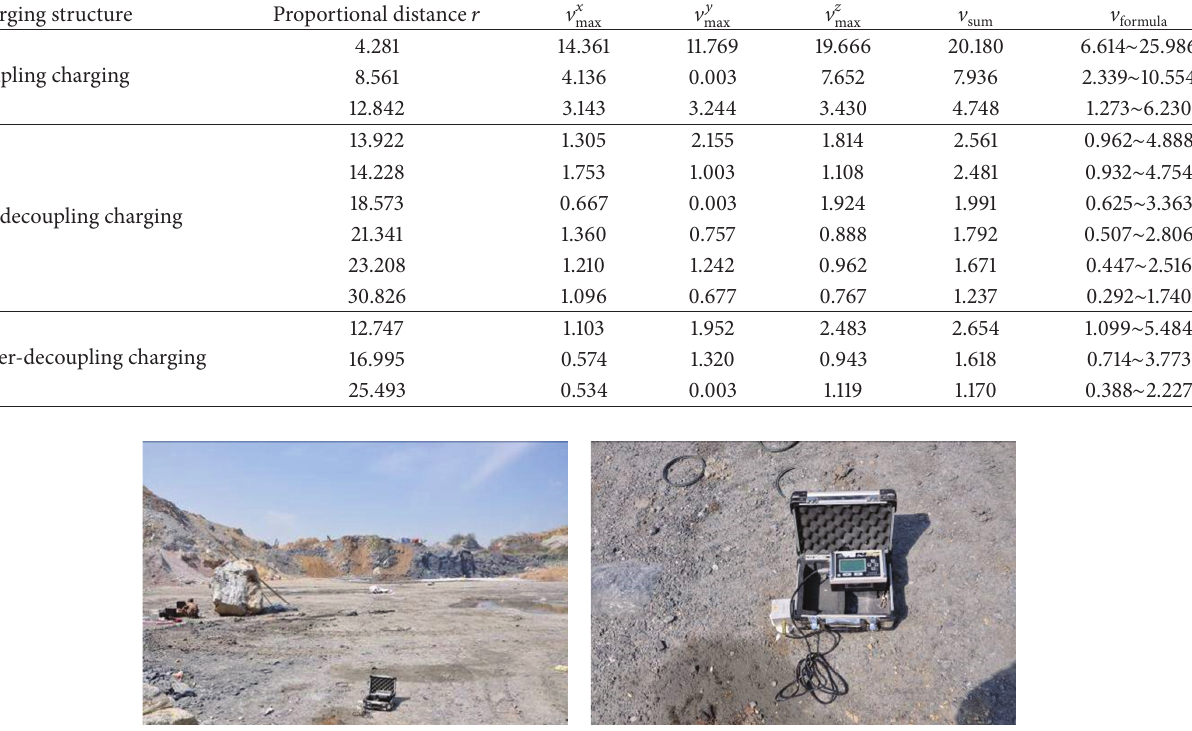
Figure 2: Site layout of blasting vibration